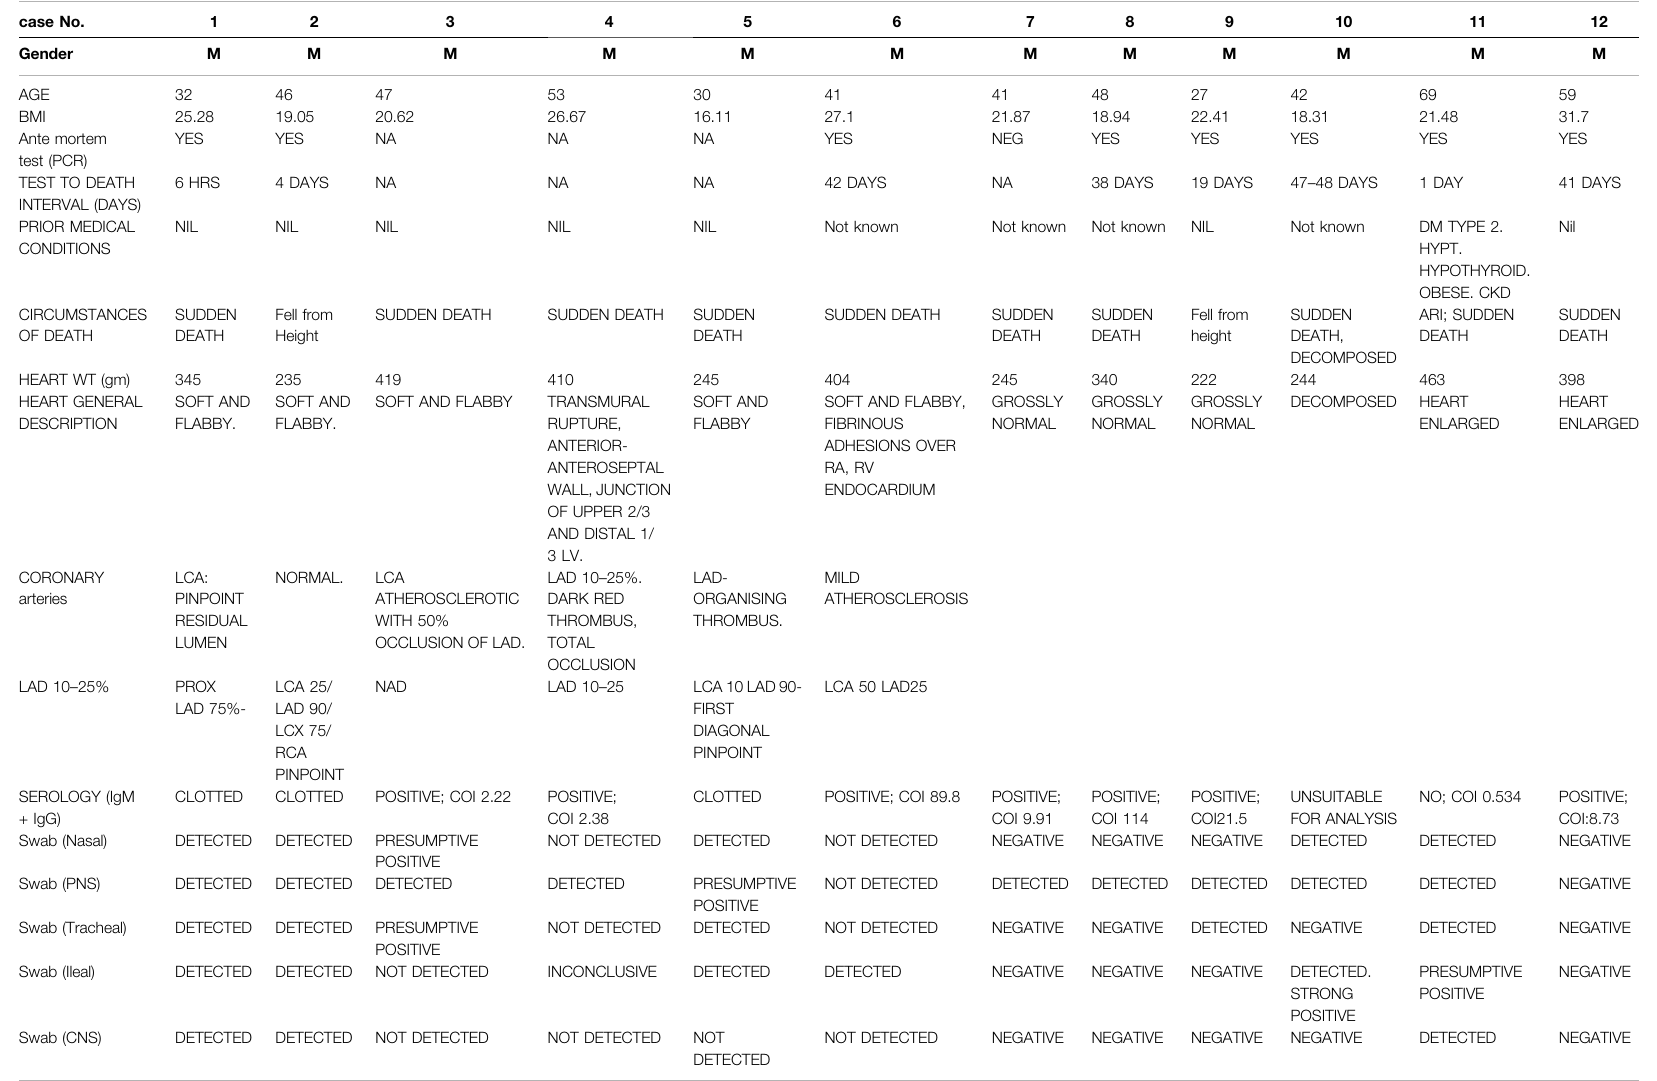
TABLE 1 | Patient characteristics and autopsy fi ndings. case No.